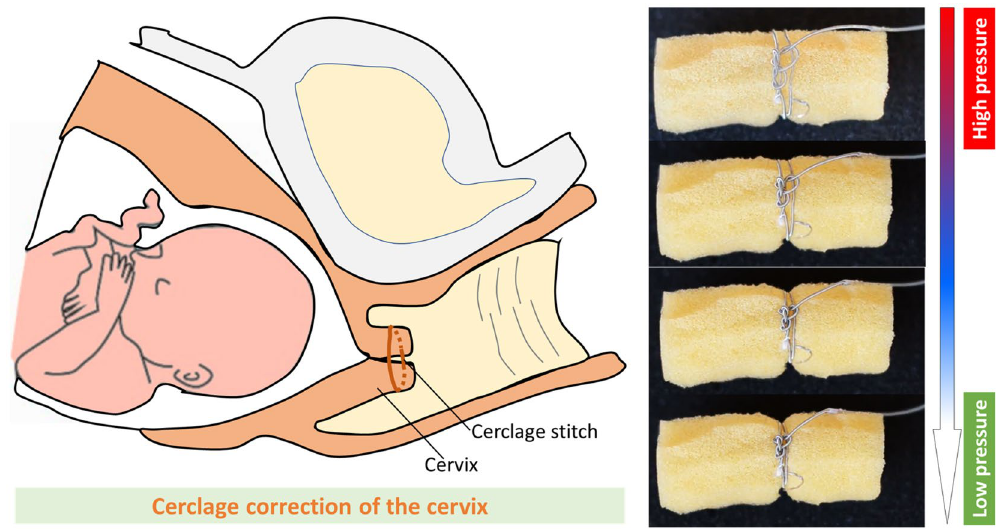
Figure 9. Proof of concept for the cerclage correction of the cervix with the S 2 suture-knot. The prototype is pressurized to 60% elongation, wrapped around a soft foam, tied a knot, and finally released the fluid pressure to self-tighten and secure the